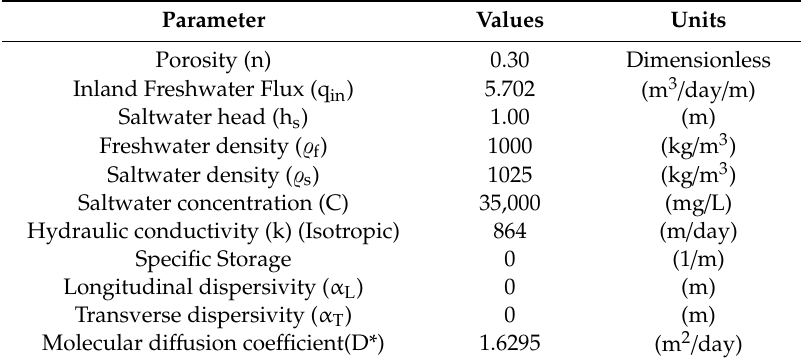
Table 1. Hydraulic parameter of Henry